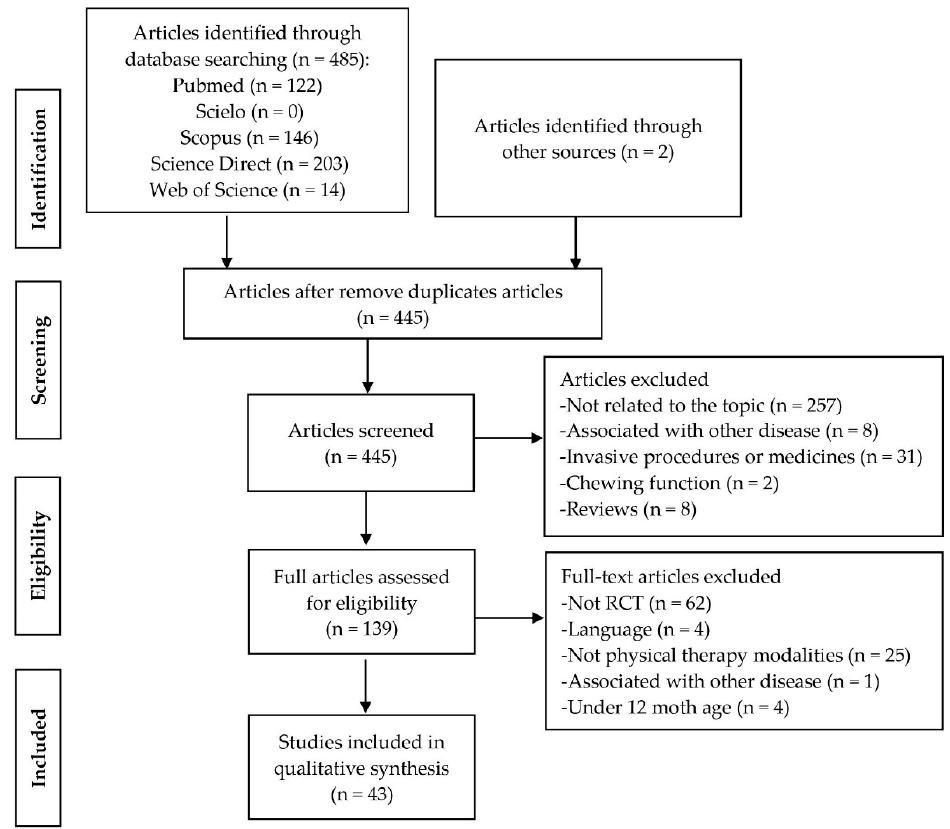
Figure 1. Flowchart of study selection in electronic databases.